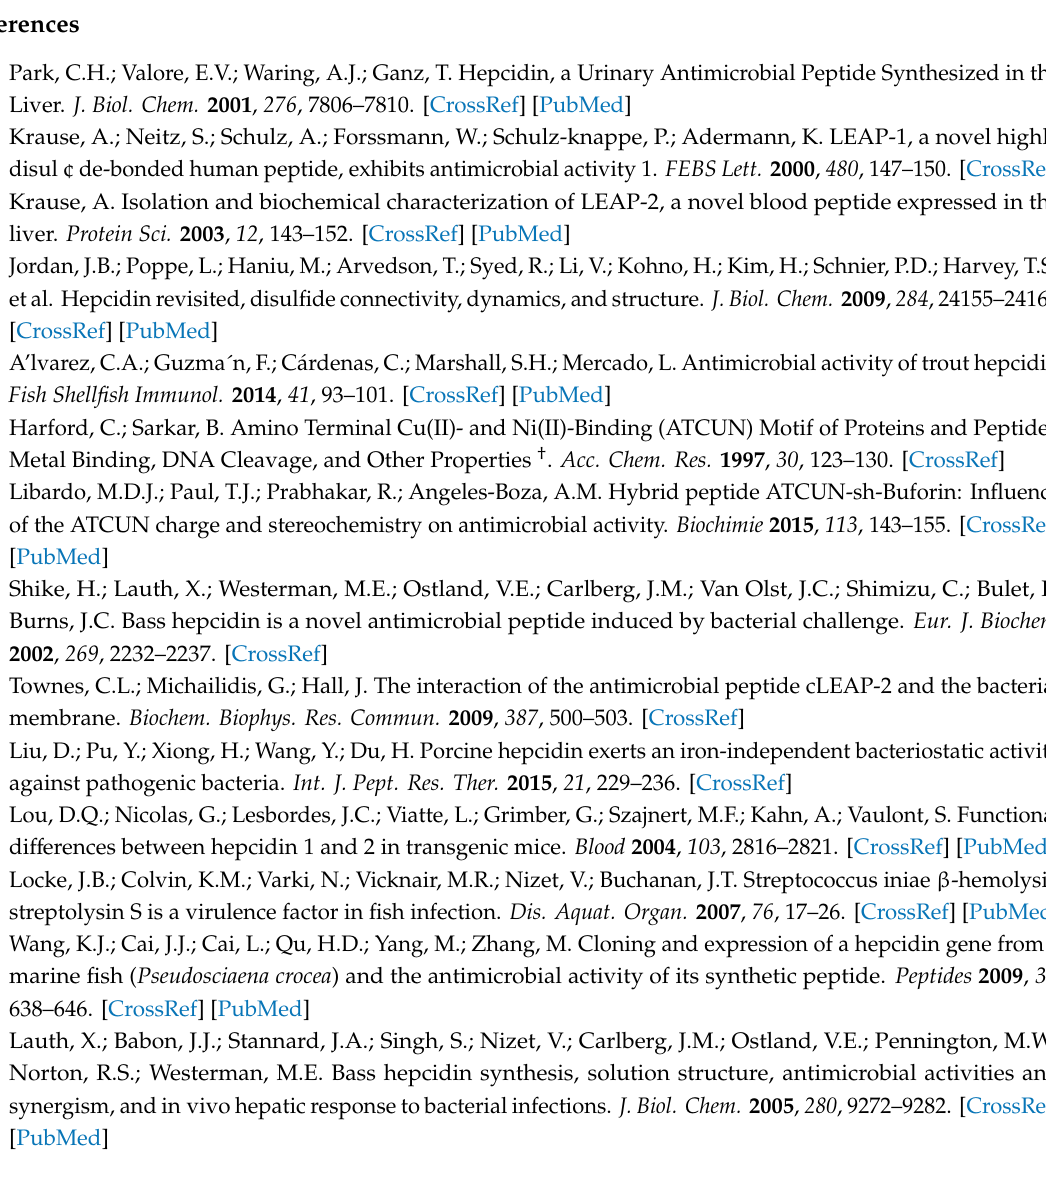
Figure S1: Emission spectra of Ethidium bromide (5 µ M) bound to the DNA (20 µ M) in the presence of varying concentrations of LEAPs from 0 to 18 µ M at the interval of 10